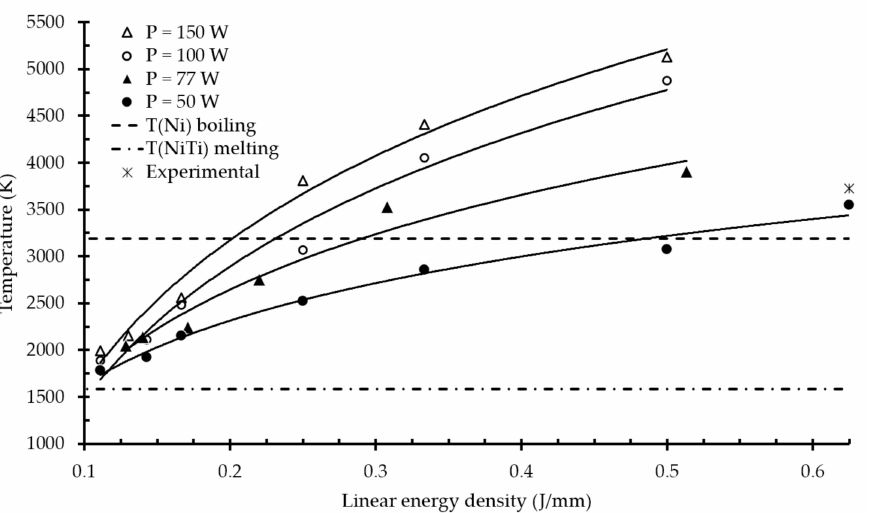
Figure 12. Peak temperature at the center of the laser beam for all combinations of parameters. The experimental result marked with an asterisk was taken from